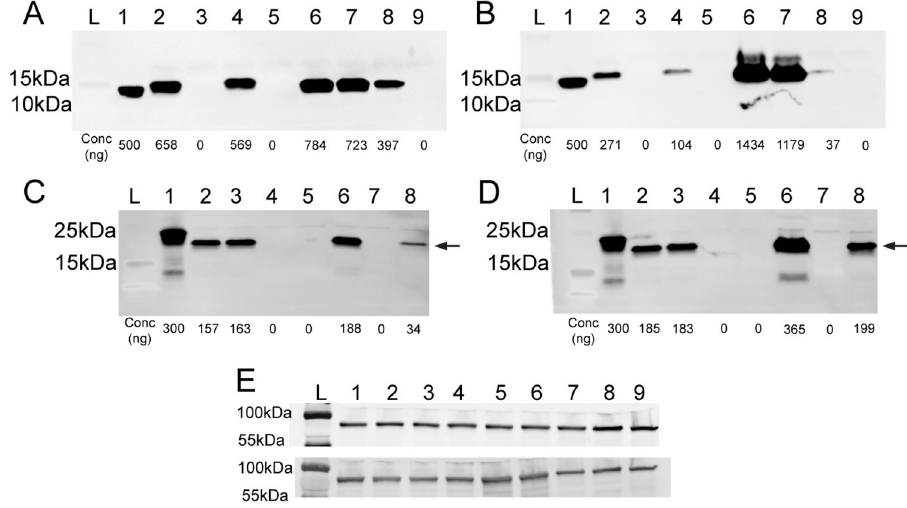
Fig 2. Expression of CFA/I and CS21 by ETEC strains grown in CFA agar or Terrific broth. ETEC strains were grown on CFA agar (A, C, E top) or in Terrific broth overnight static culture (B, D, E bottom). Whole cell bacterial lysates were probed with anti-CFA/I (A and B), anti-CS21 antibodies (C and D), or anti-DnaK antibodies (E). Panels A and B: ladder (L); lane 1, purified CFA/I (500ng); lane 2, CVD30; lane 3, CVD30 Δ cfaB ; lane 4, CVD30 Δ lngA ; lane 5, CVD30 Δ cfaB Δ lngA ; lane 6, CVD30 Δ cfaB (pGA2-CFA/I); lane 7, CVD30 Δ cfaB Δ lngA (pGA2-CFA/I); lane 8, H10407; and lane 9, H10407Kan. Panels C and D: ladder (L); lane 1, purified LngA (300ng); lane 2, CVD30; lane 3, CVD30 Δ cfaB ; lane 4, CVD30 Δ lngA ; lane 5, CVD30 Δ cfaB Δ lngA ; lane 6, CVD30 Δ cfaB (pGA2-CFA/I); lane 7, CVD30 Δ cfaB Δ lngA (pGA2-CFA/I); and lane 8, E9034A. Protein concentrations of CFs (ng) were determined using densitometry. Arrow indicates band size for LngA. Purified CFA/I results in a CfaB band that migrates faster than that in whole cell lysates. Purified LngA is tagged by a 6X His tag (21kDa) while LngA in whole cell lysates result in a band at 19kDa. DnaK western blots confirmed equal loading of samples. Panel E: ladder (L); lane 1, CVD30; lane 2, CVD30 Δ cfaB ; lane 3, CVD30 Δ lngA ; lane 4, CVD30 Δ cfaB Δ lngA ; lane 5, CVD30 Δ cfaB (pGA2-CFA/I); lane 6, CVD30 Δ cfaB Δ lngA (pGA2-CFA/I); lane 7, H10407; lane 8, H10407Kan; and lane 9,